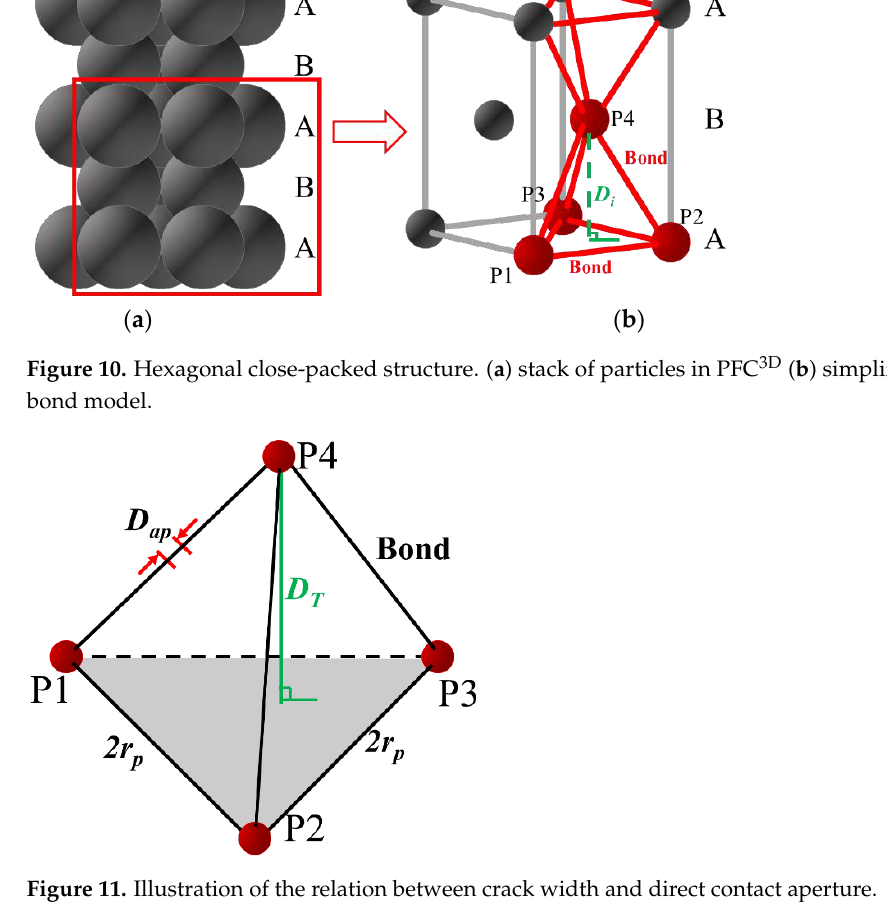
Figure 11. Illustration of the relation between crack width and direct contact aperture.